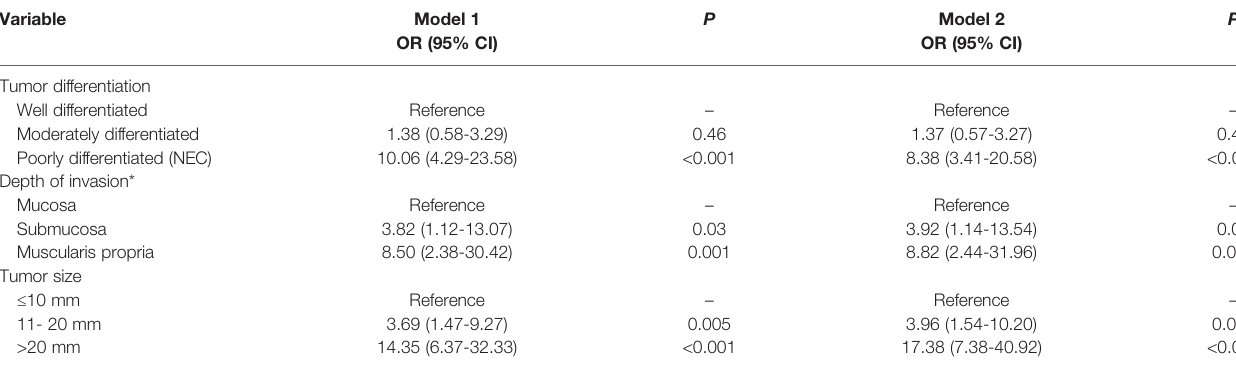
TABLE 3 | Logistic regression of factors associated with LNM in patients with g-NENs.